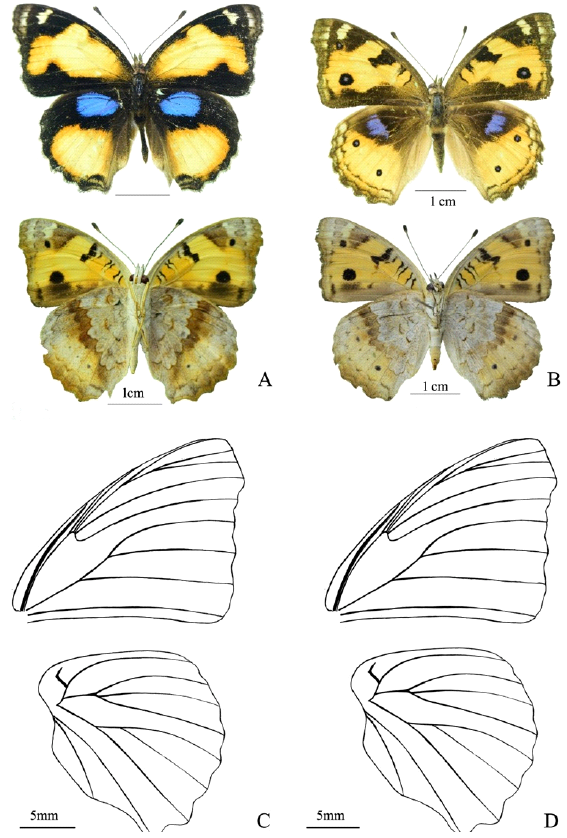
Figure 13. Junonia hierta (Fabricius, 1798) A - male; B - female; C - wing venation (male); D - wing venation